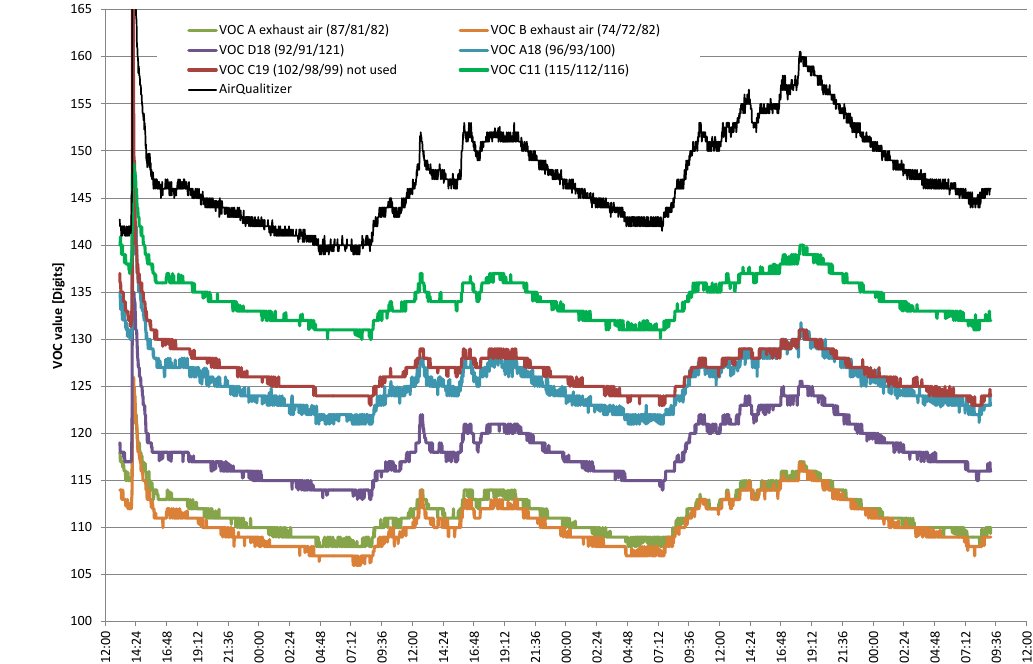
Figure 13. Signal dynamics of six used VOC sensors from the field test and one AirQualitizer (AirQualitizer, 2012) in an office